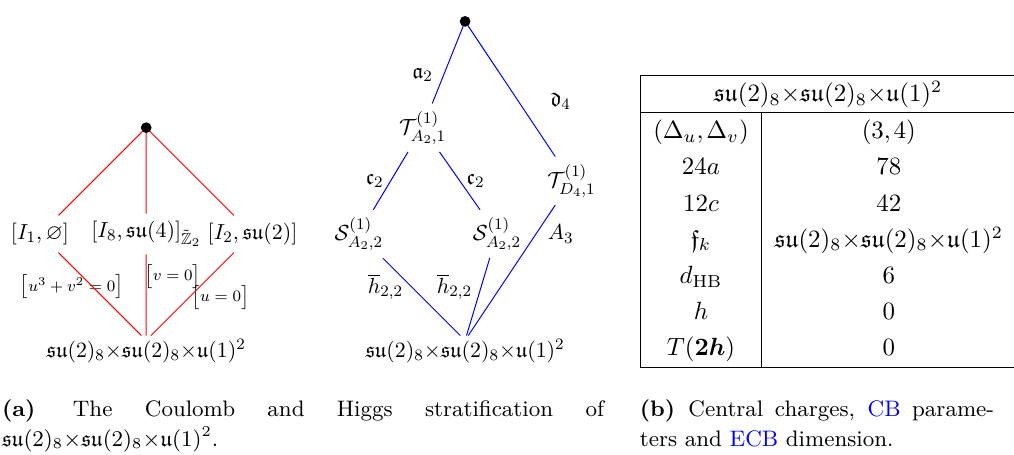
Figure 26. Information about the su (2) 8 × su (2) 8 × u (1) 2